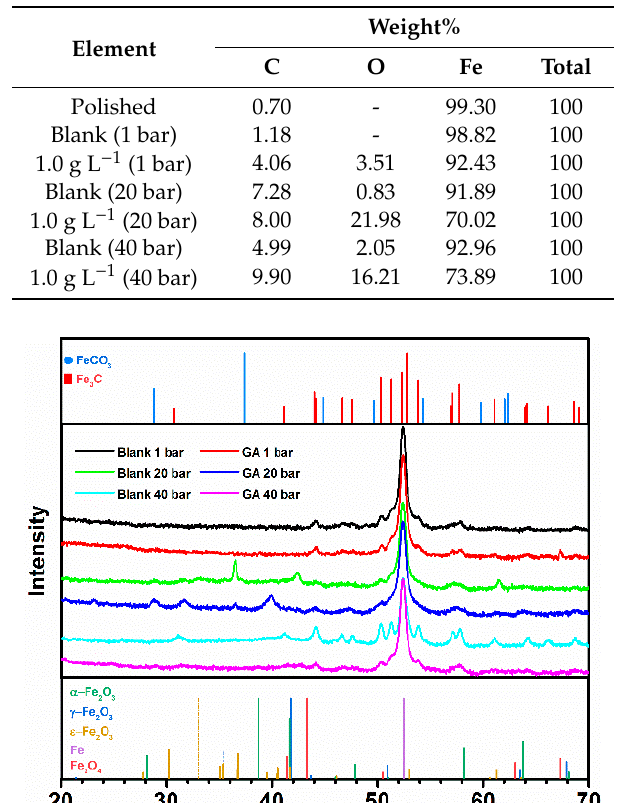
Table 4. Weight percentage of the elements calculated from EDS analyses.